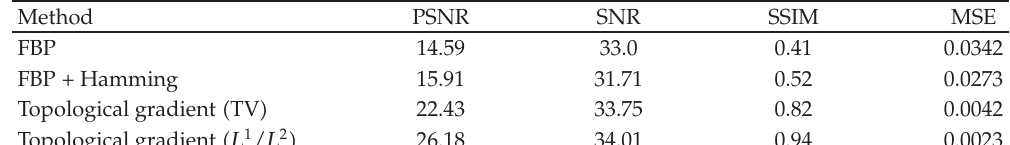
Table 1: Comparison between several reconstruction methods, quantified by several ratios and similarity indexes, for a noisy sinogram with SNR (cid:10) 24 . 5.